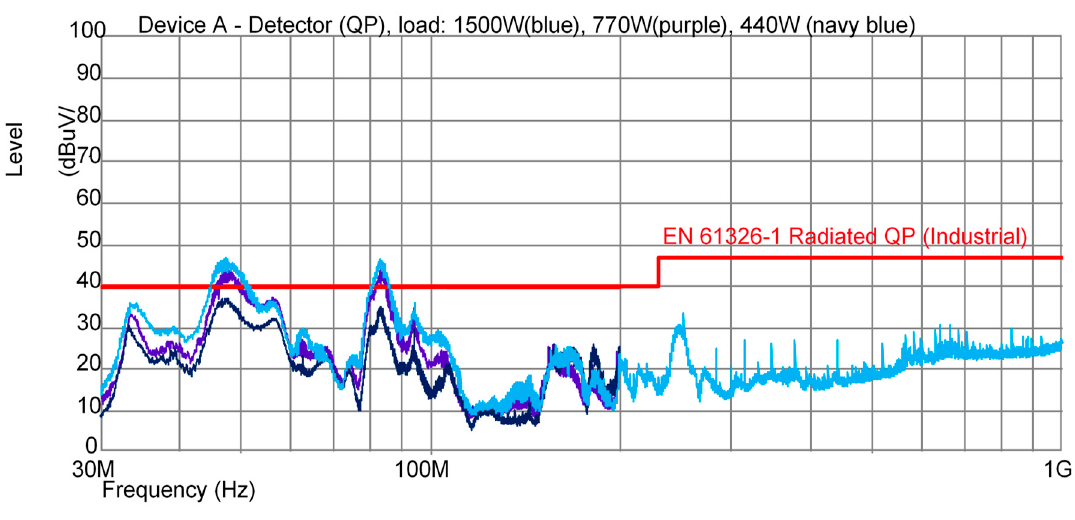
Figure 8. Frequency spectrum of radiated emission of audio power amplifier (device B) for frequencies of generated volt- age by the device under test equal to 50 and 1000 Hz.